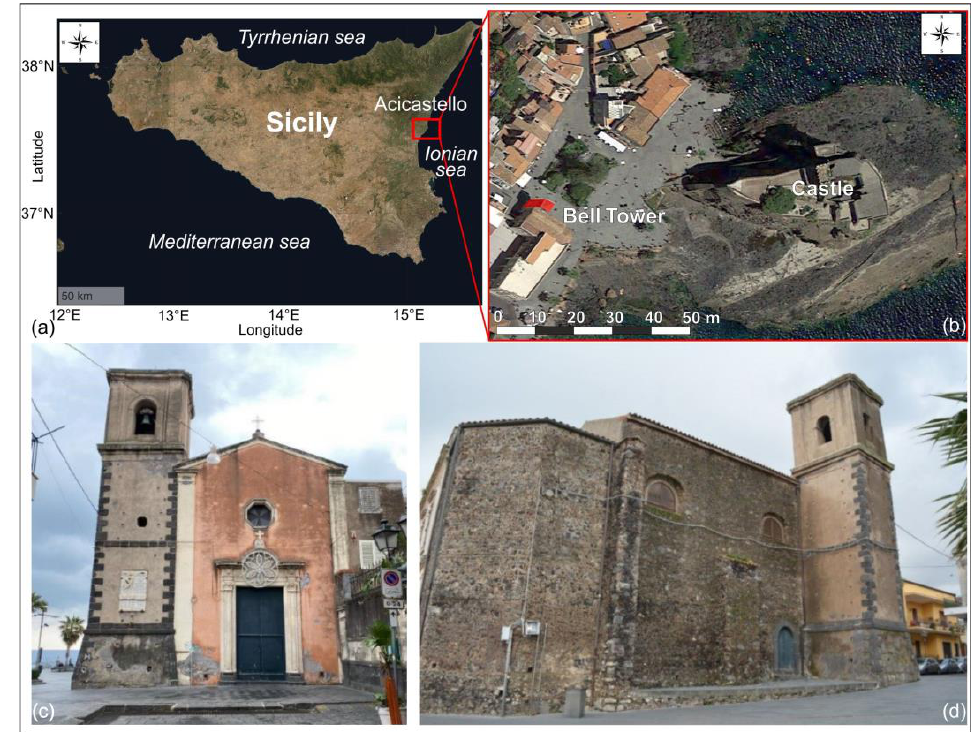
Figure 1. ( a ) Location of Aci Castello municipality (Sicily), ( b ) position of San Giuseppe’s bell tower (highlighted in red), ( c ) west and ( d ) north views of the San Giuseppe church.